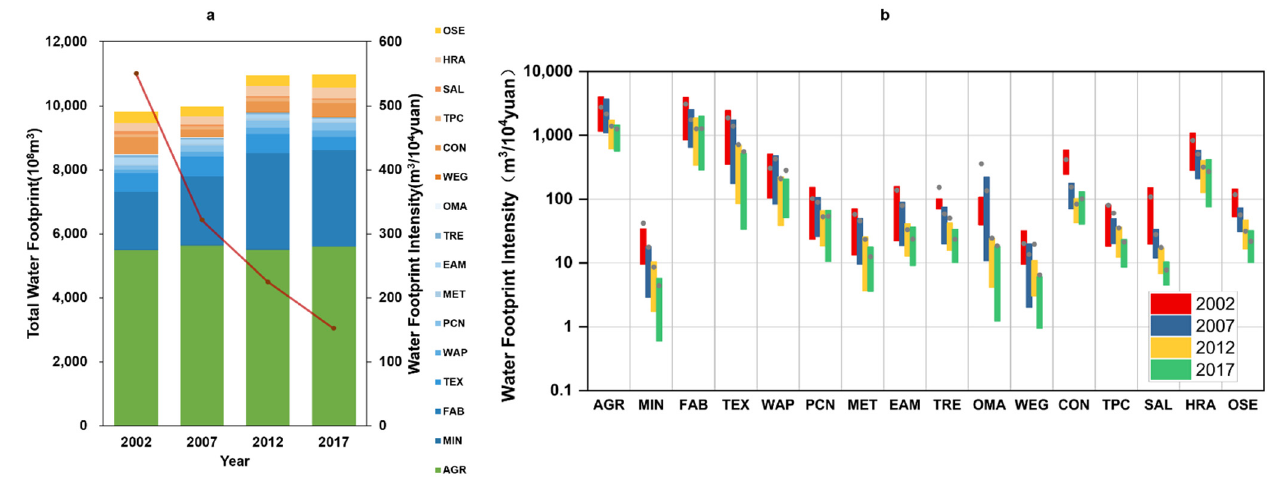
Figure 2. The water footprint and water footprint intensity from 2002–2017. Here, ( a ) shows the water footprint in 2002, 2007, 2012, and 2017 across all sectors, and ( b ) is water footprint intensity of each sector from 2002 to 2017.